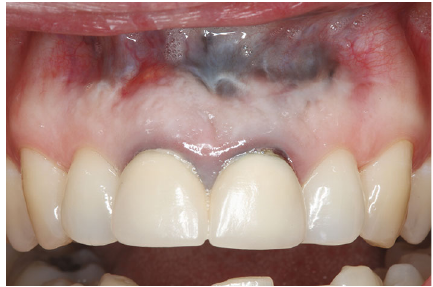
Figure 23: Clinical view one year after surgery: note the correct soft tissue healing.